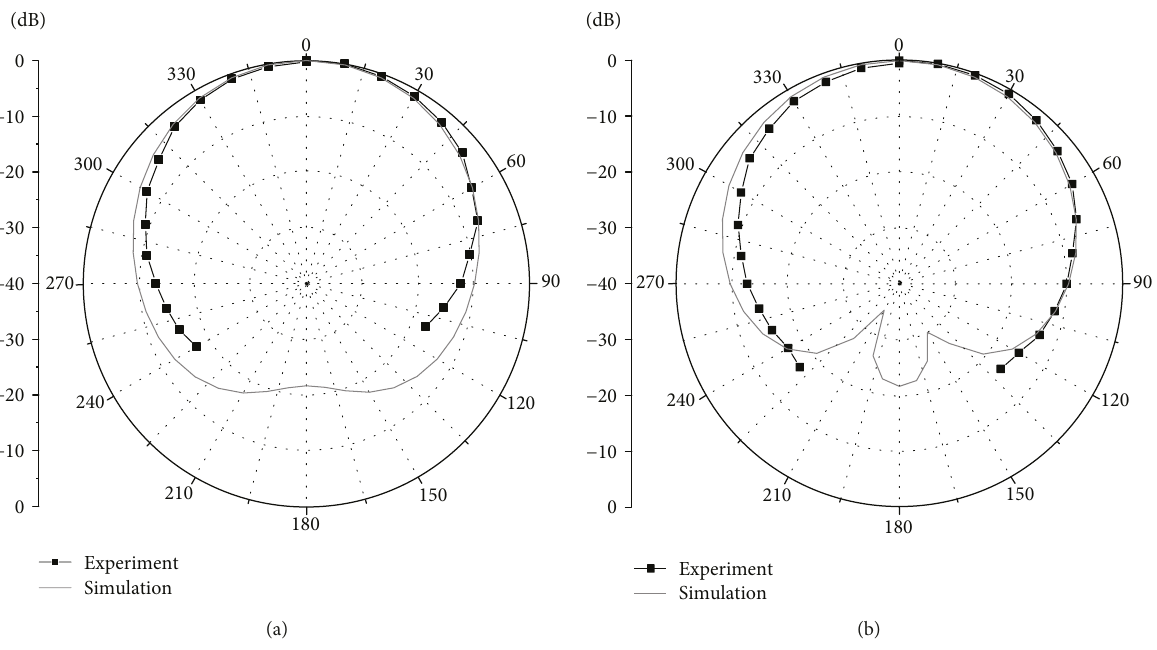
Figure 11: The measured radiation patterns of the tag antenna on a 200 mm × 200mm metal plane. (a) E plane. (b) H plane. Table 1: Read ranges of the tag on di ff erent metal planes.